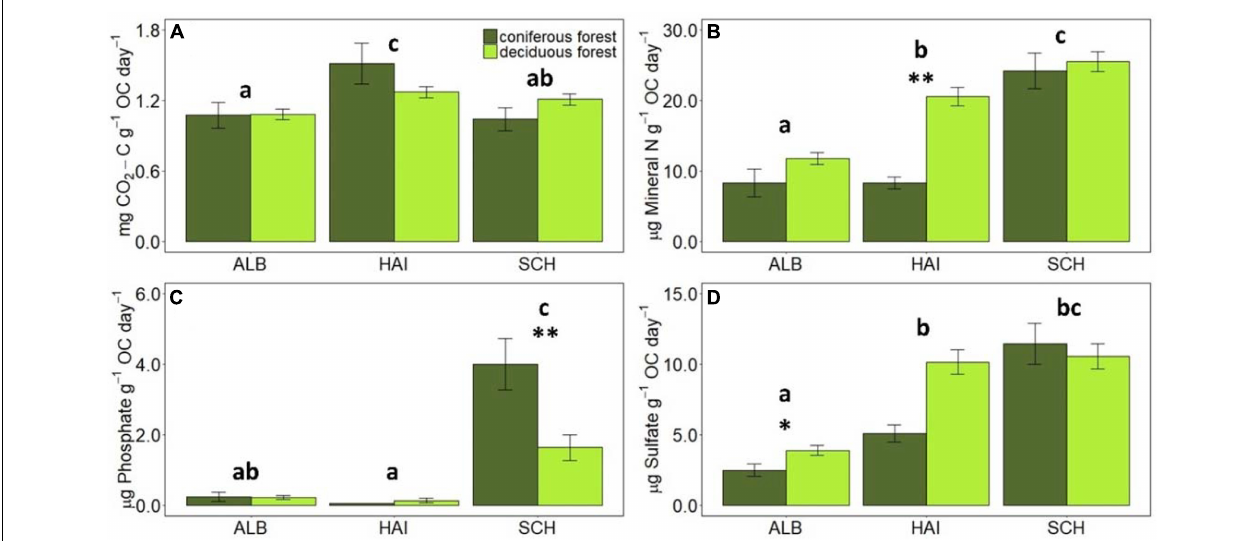
FIGURE 3 | Comparison of average mineralization rates of C, N, P, and S normalized to SOC values in different study regions and forest types. Error bars represent SE of means. X -axis represents study regions where ALB, Schwäbische-Alb; HAI, Hainich-Dün; SCH, Schorfheide-Chorin. Significant differences of variance between study regions are denoted by small letters, and between coniferous and deciduous forests by ∗ P < 0.05 and ∗∗ P < 0.01. Number of study sites included: ALB (deciduous forests, n = 38 and coniferous forest, n = 12), HAI (deciduous forests, n = 46 and coniferous forest, n = 4), and SCH: (deciduous forests, n = 28 and coniferous forest, n =